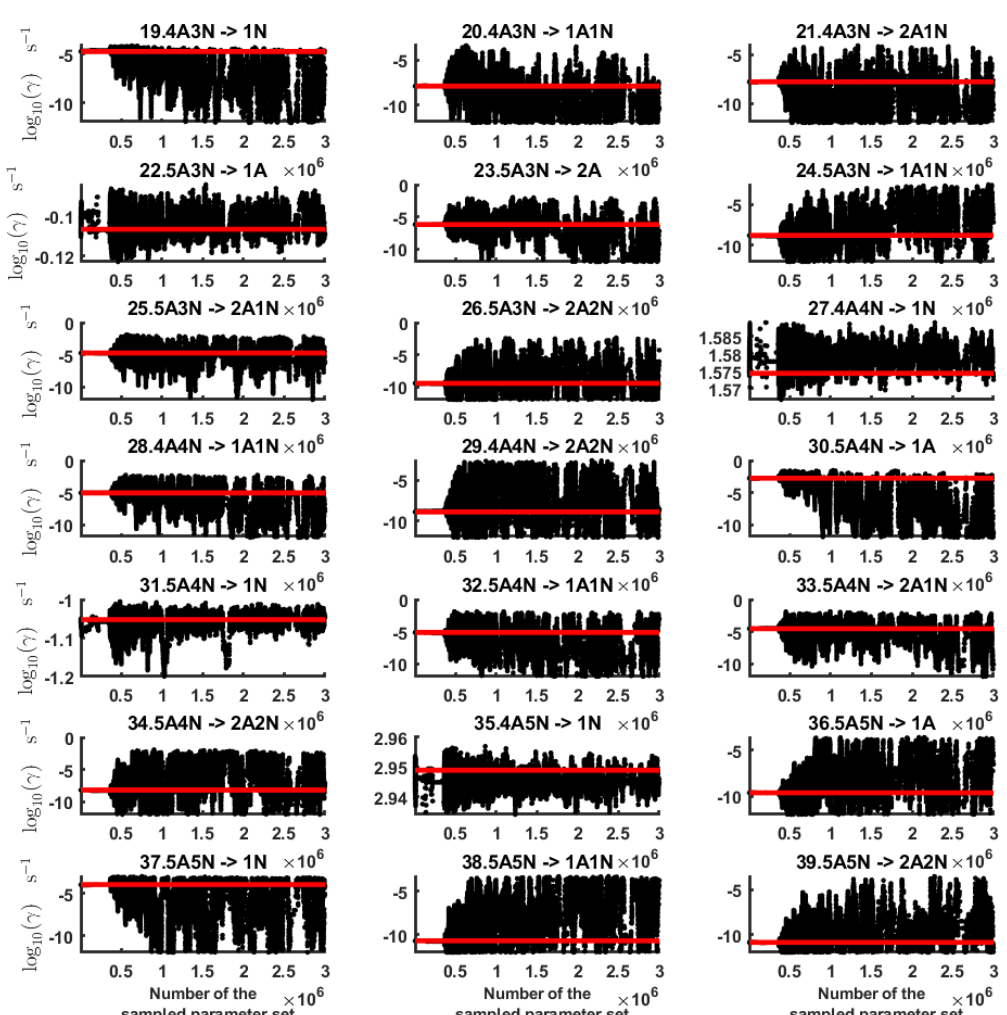
Figure B2. Parameter chains (for parameter indexes ranging from 19 to 39) of the base 10 logarithm of the evaporation rates (units given in s − 1 ) determined from steady-state cluster concentration measurements at the temperature 278K. Red lines denote the baseline values from Olenius et al. (2013b) used to generate the synthetic data. The notation xAyN corresponds to a cluster with x sulfuric acid and y ammonia